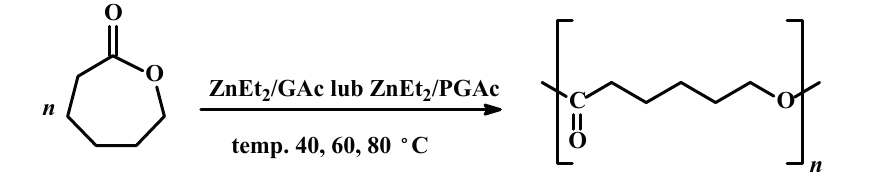
Figure 1. Structure of gallic acid and propyl